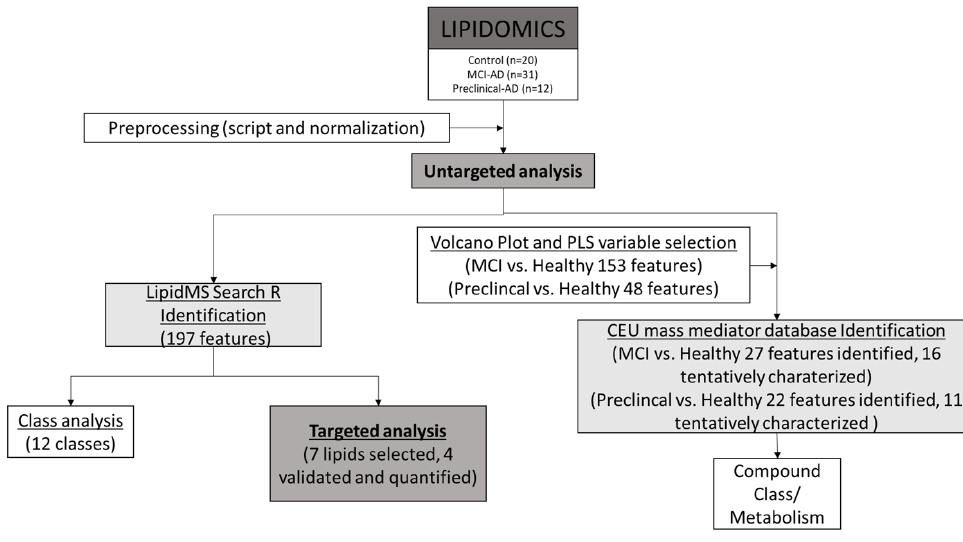
Figure 1. Workflow of the analyses.